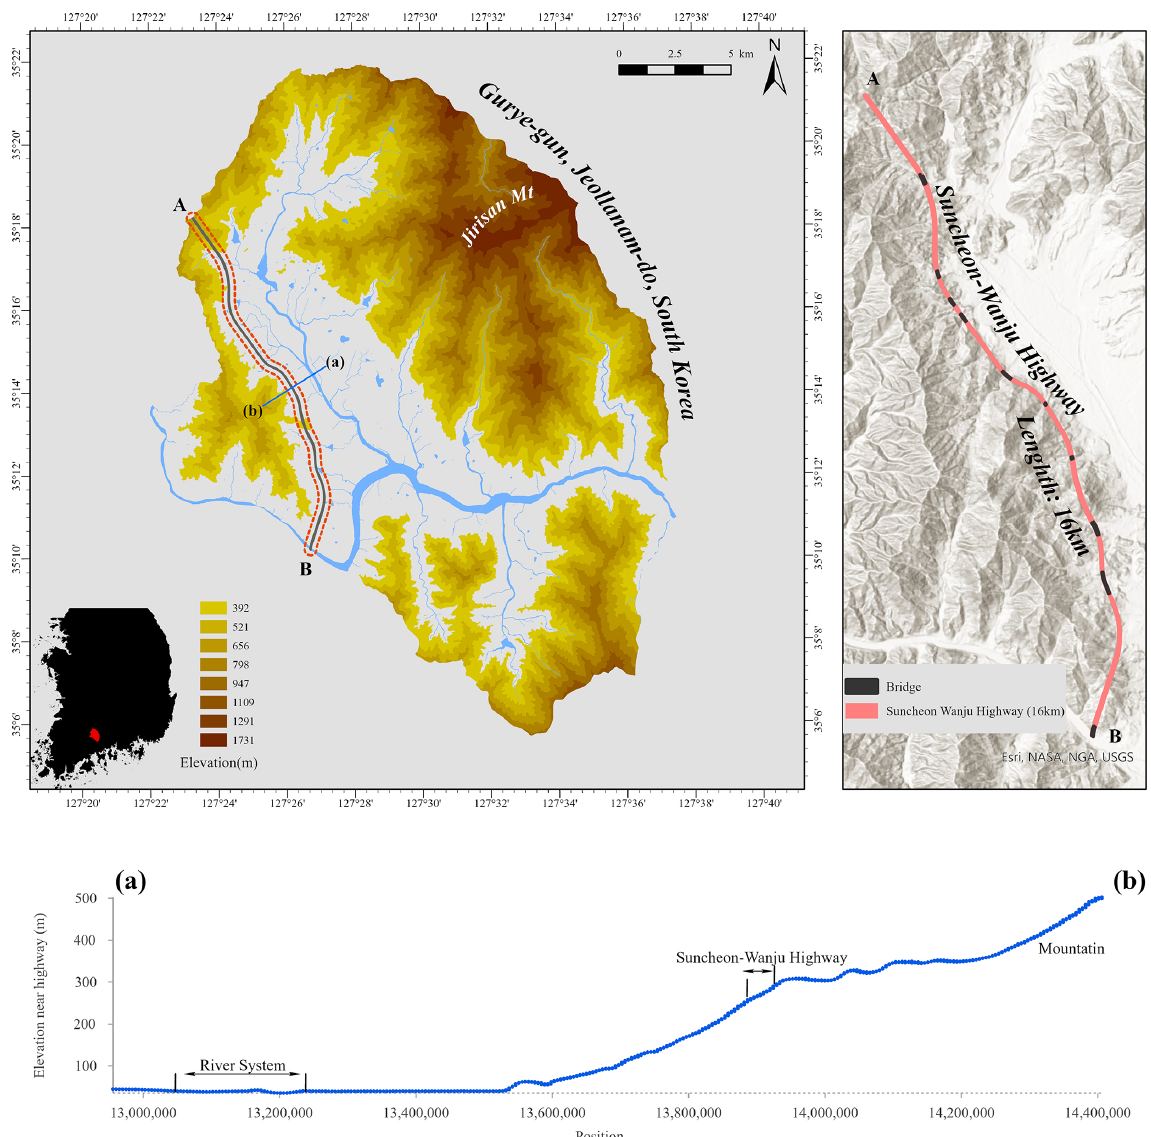
Figure 5. Suncheon–Wanju Highway, Gurye-gun, Jeollanam-do, a research area for system dynamics model. The Suncheon–Wanju Highway in Gurye-gun (16km), Jeollanam-do, runs from point A (35 ◦ 18 (cid:48) S) to point B (35 ◦ 10 (cid:48) S). If the section from (a) to (b) is selected, and the cross-section is analysed, mountains and water systems are observed to the left and right (source: DEM created by the lidar method at the